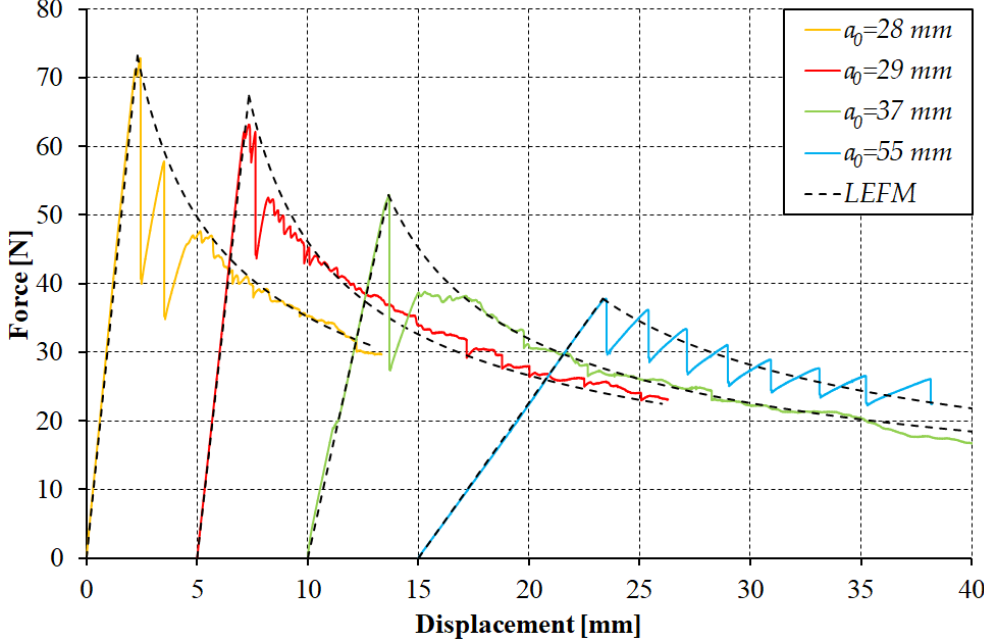
Figure 3. Load-displacement curve obtained from the DCB tests.